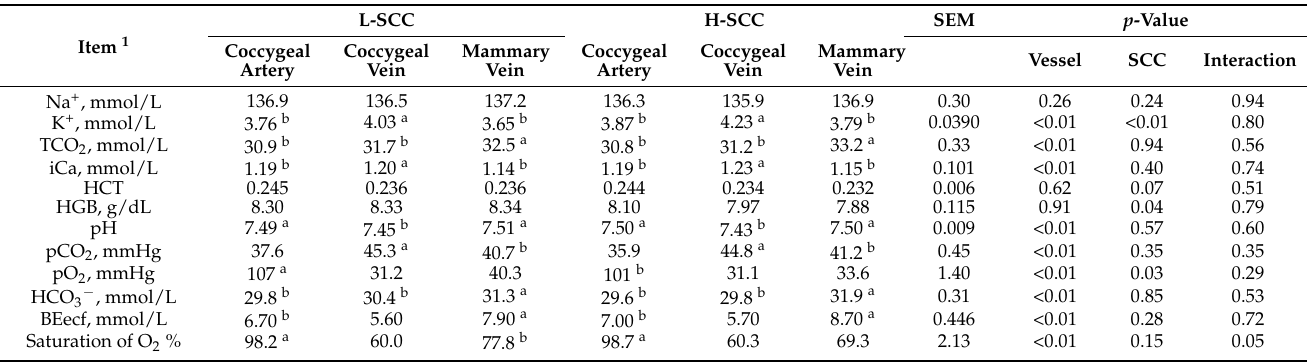
Table 2. Blood gas profile comparison in coccygeal artery, coccygeal vein, and mammary vein in high-yielding dairy cows with high and low somatic cell counts (SCCs).